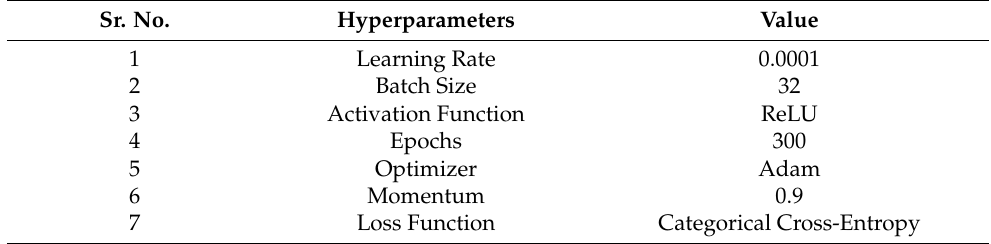
Table 4. Diagnostic test for the prevalence of the disease. Sr.